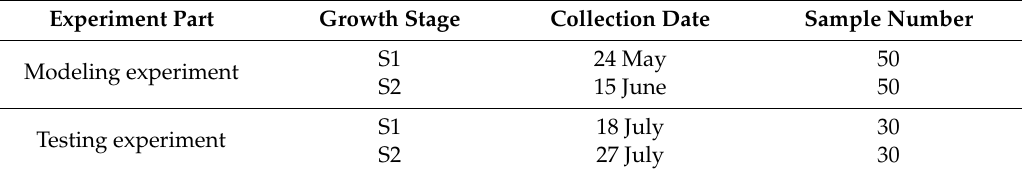
Table 2. Details of the spectral data